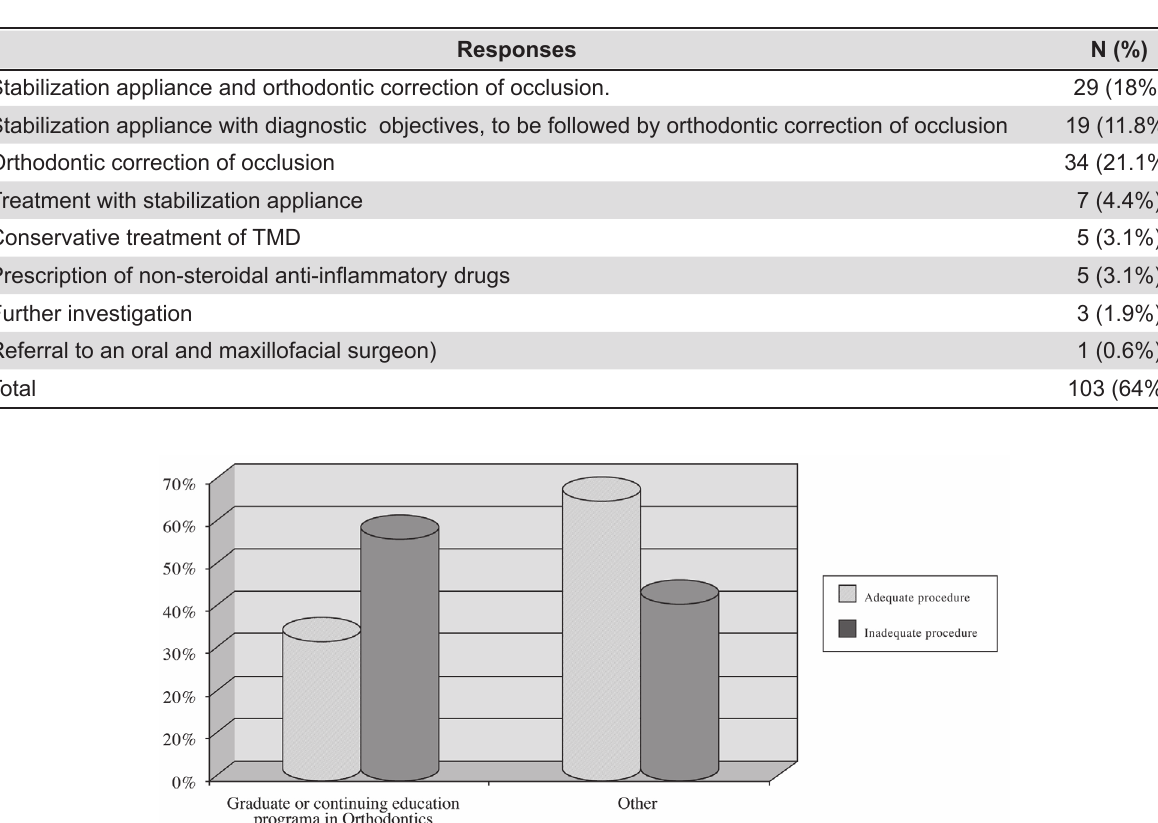
Table 2- Valid responses with procedures considered to be